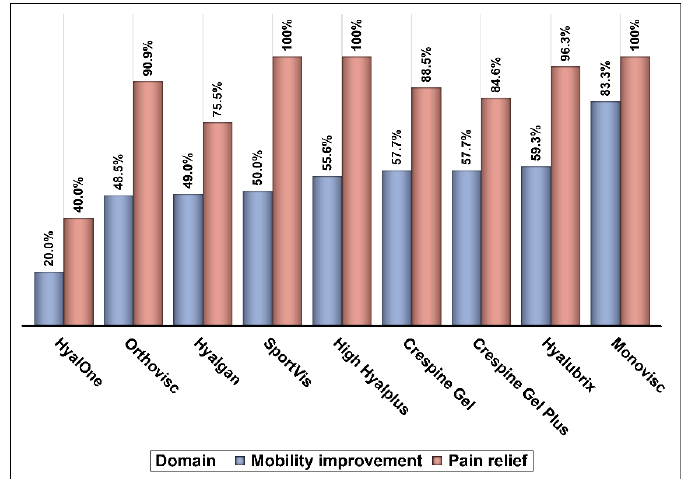
Figure 3. The effectiveness ratings of hyaluronic acid products.